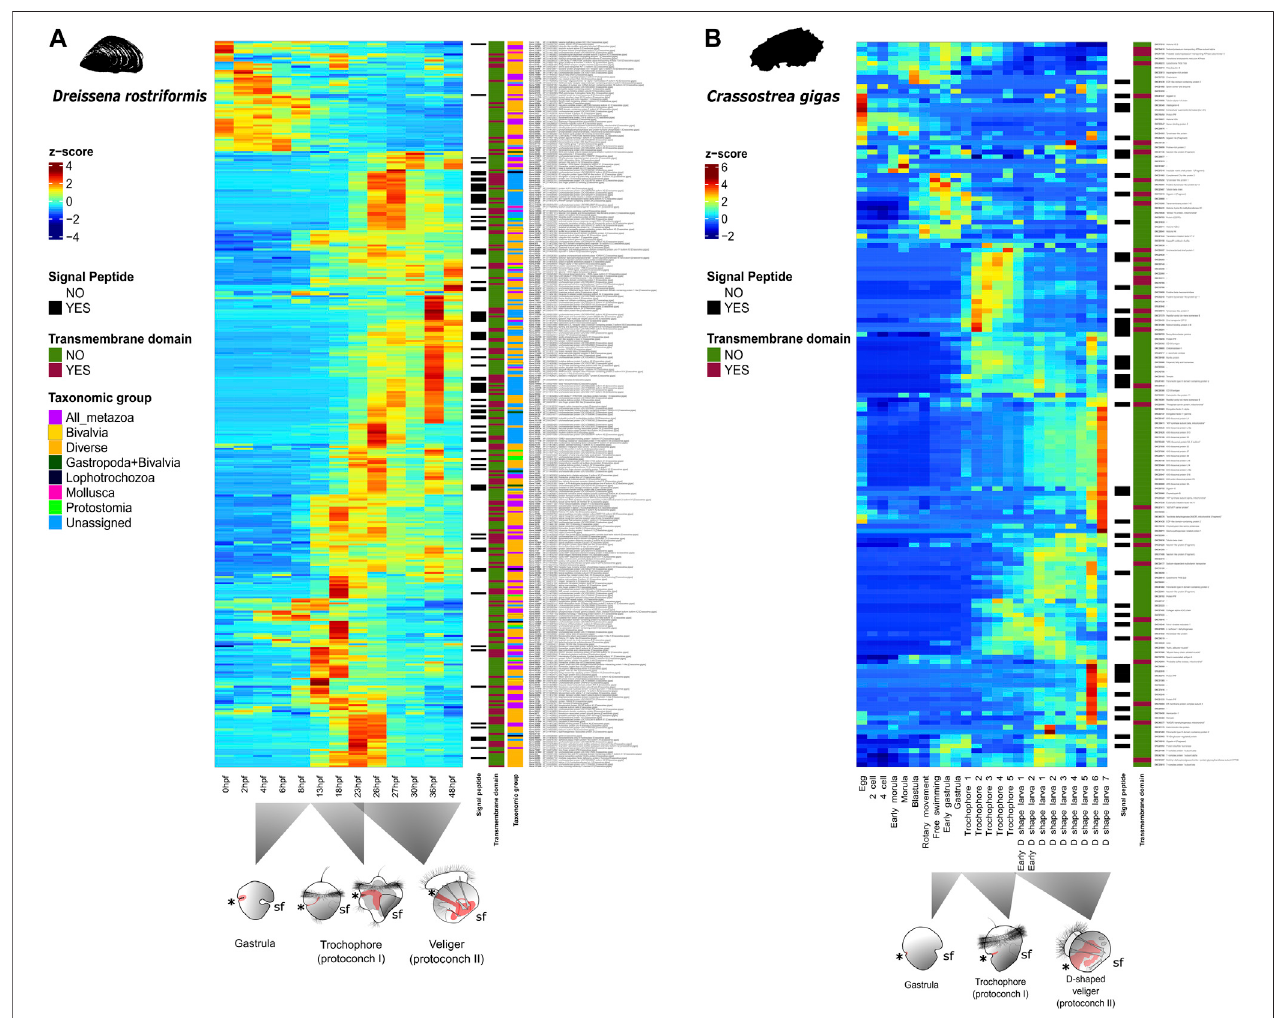
FIGURE 2 | Relative quantitative expression of shell fi eld-speci fi c genes during development of two bivalve species. (A) Heat map showing relative normalized expression levels for each isolated gene from the shell fi eld of the trochophore of Dreissena rostriformis . Normalized gene expression (transcripts per million; TPM) is depicted in graded shades of red when values are above the median, those below this threshold and with a value close to zero are in shades of blue. Details on gene annotations, orthogroup assignments to the respective taxonomic level, presence of signaling peptides, and transmembrane domains are provided in SupplementaryTableS2 .BlasttophittothePaci fi coysterisnexttoeachgenename.Timeafterfertilization(hpf)andcorrespondingdevelopmentalstagesat23 ° Care ordered chronologically at the bottom of the x axis. Germ layers and their major derivatives in animal schemes are depicted in grey (mesoderm), red (endoderm), and white (ectoderm), respectively. Asterisks mark the blastopore/mouth, sf indicates the shell fi eld. (B) Heat map showing relative normalized expression levels of genes isolatedfromlarvalandadultshellsof Crassostreagigas asdescribedinZhaoetal.(2018).Normalizedgeneexpressionisdepictedingradedshadesofredwhenvalues are abovethe median, thosebelowthisthreshold andwithavalueclose tozeroare inshades ofblue. Each developmentalstage isorganized chronologicallyfrom leftto rightonthe x axis.Detailsongeneannotations,orthogroupassignments,presenceofsignalingpeptides,andtransmembranedomainsareprovidedin Supplementary Table S9 (cf. Zhao et al.,